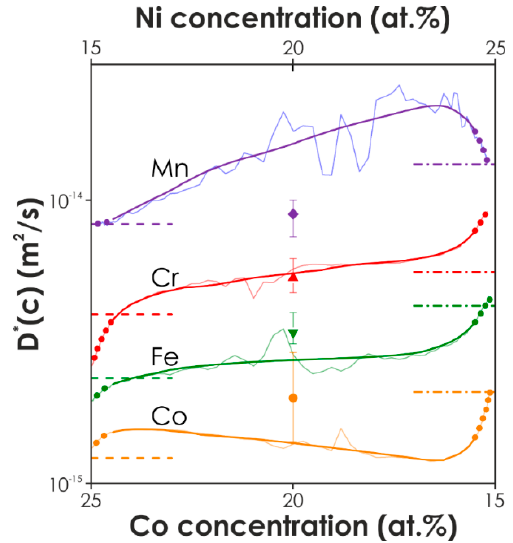
Figure 23. Tracer diffusion coefficients of Co, Cr, Fe, and Mn as a function of the Co concentration (represented by solid lines) compared with the tracer diffusion coefficients measured in the sides with constant constituent concentration (represented by dashed lines for the Co-rich side and dashed-dot lines for the Ni-rich side) and with the tracer diffusion coefficients measured in single-crystalline CoCrFeMnNi HEA (represented by filled symbols) [40]. The dotted lines show the determined tracer diffusion coefficients for the near end-member compositions (after [43]). Reprinted from Acta Materialia 166 (2019), Concentration-dependent atomic mobilities in FCC CoCrFeMnNi high-entropy alloys, 357–370, Copyright 2019, with permission from Elsevier.